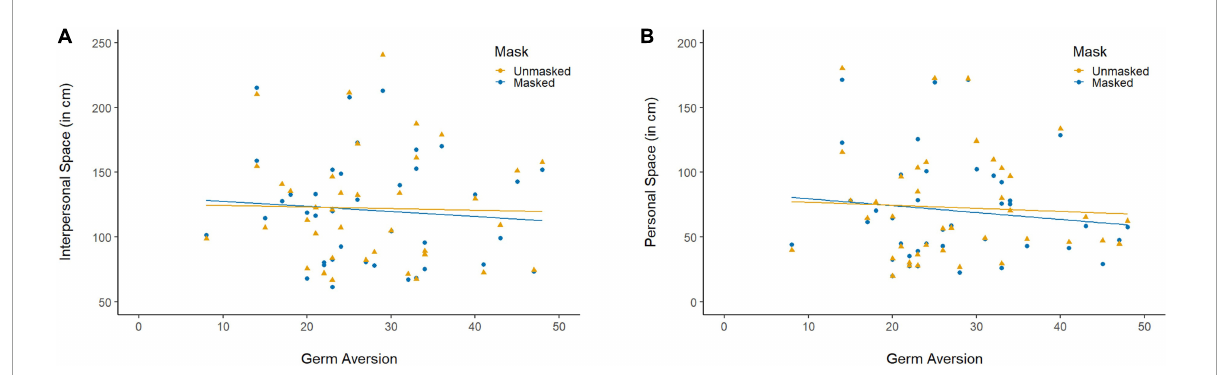
FIGURE4 The interaction between the effect of the face mask and germ aversion on (A) interpersonal space (IPS) and (B) personal space (PS).